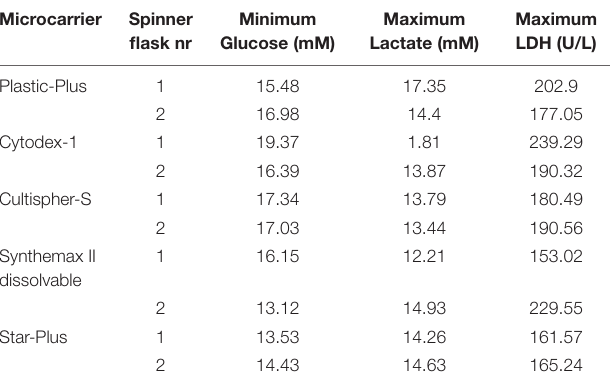
TABLE 3 | Metabolites data for hPDCs expanded during dynamic screening experiment of 8